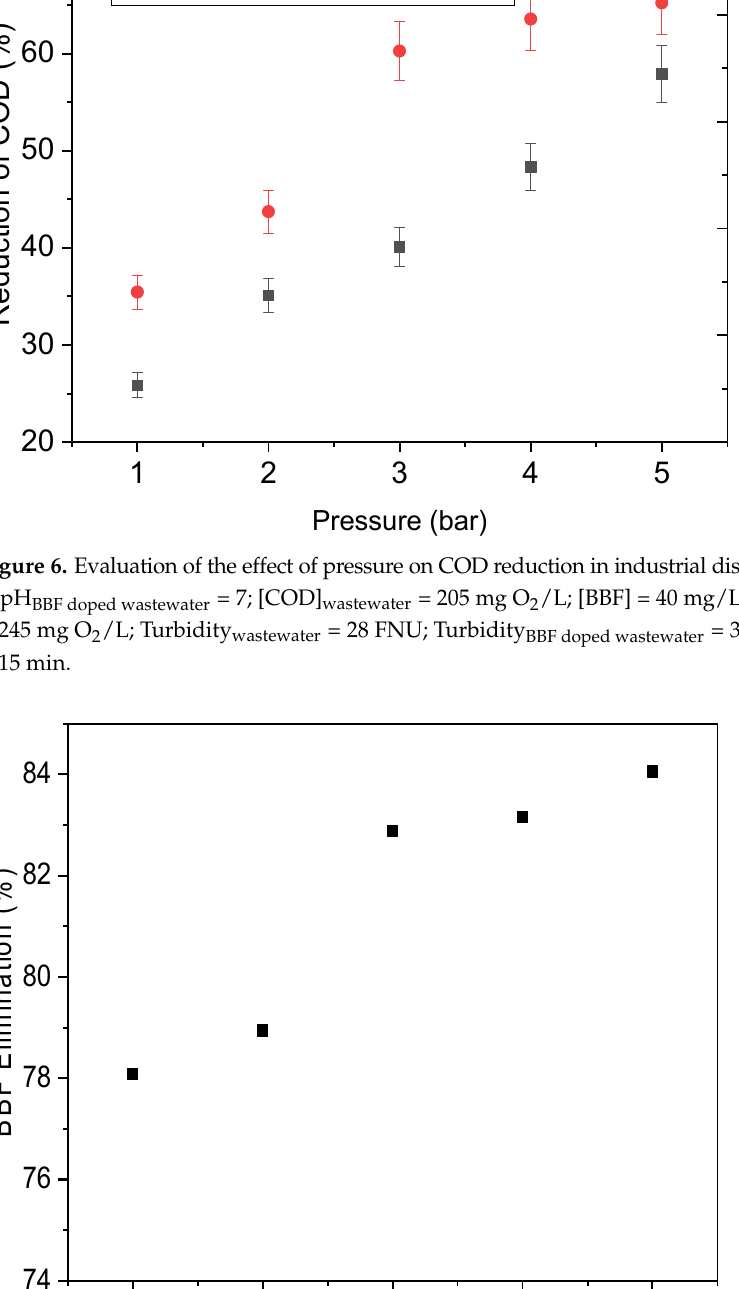
Figure 7. Evaluation of the effect of pressure on dye removal in industrial wastewater: pH wastewater = 5; pH BBF doped wastewater = 7; [COD] wastewater = 205 mg O 2 /L; [BBF] = 40 mg/L; [COD] doped wastewater = 245 mg O 2 /L; Turbidity wastewater = 28 FNU; Turbidity BBF doped wastewater = 33 FNU; treatment time = 15 min.